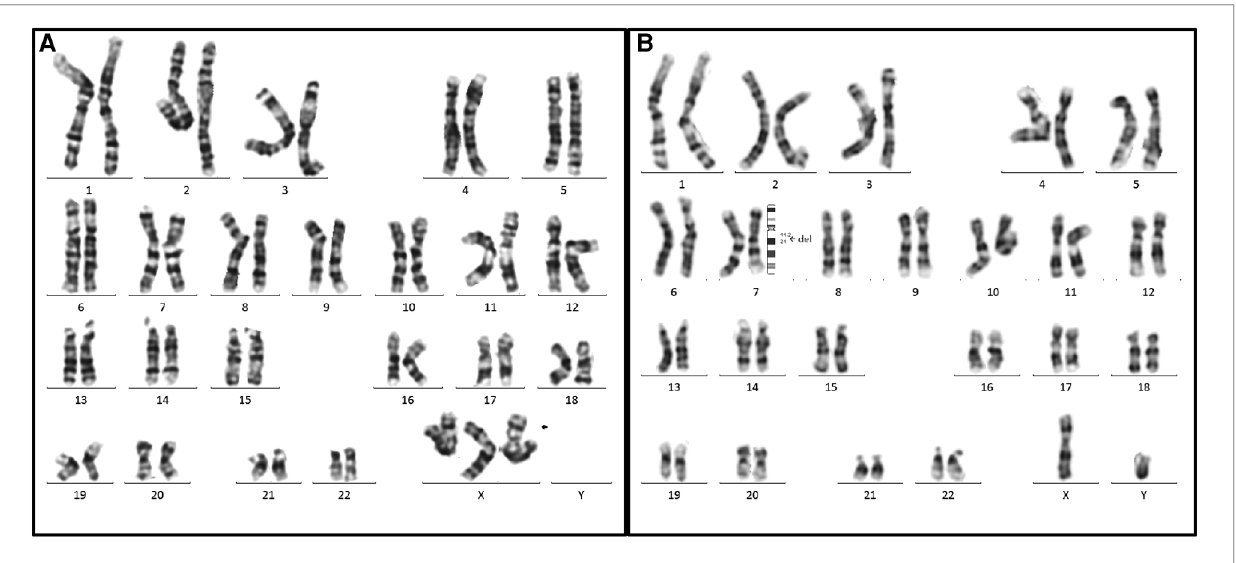
FIGURE 3 Two abnormal karyotypes in our case series. ( A ) The karyotype on the left is for the case 9 (47, XXX), the arrow indicated the extra X chromosome. ( B ) The karyotype on the right is for case 12. The arrow elicited that the breakpoints of the deletion were located between 7q11.2 and 7q21, and the karyotype was described as 46,XY, del(7)(q11.2q21).